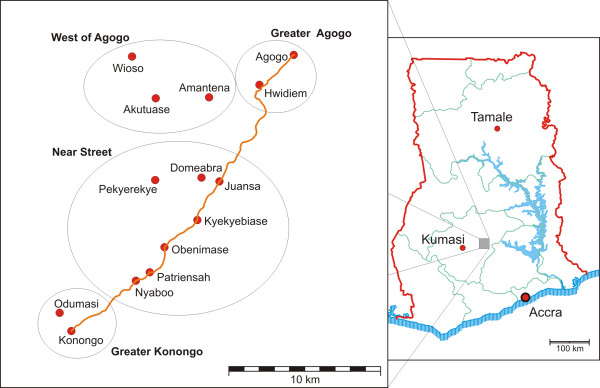
Map of the 14 included villages and village clusters in the Asante Akim North District, Ashanti Region, central Ghana, West Africa. Red dots indicate villages; the solid line indicates the main road.